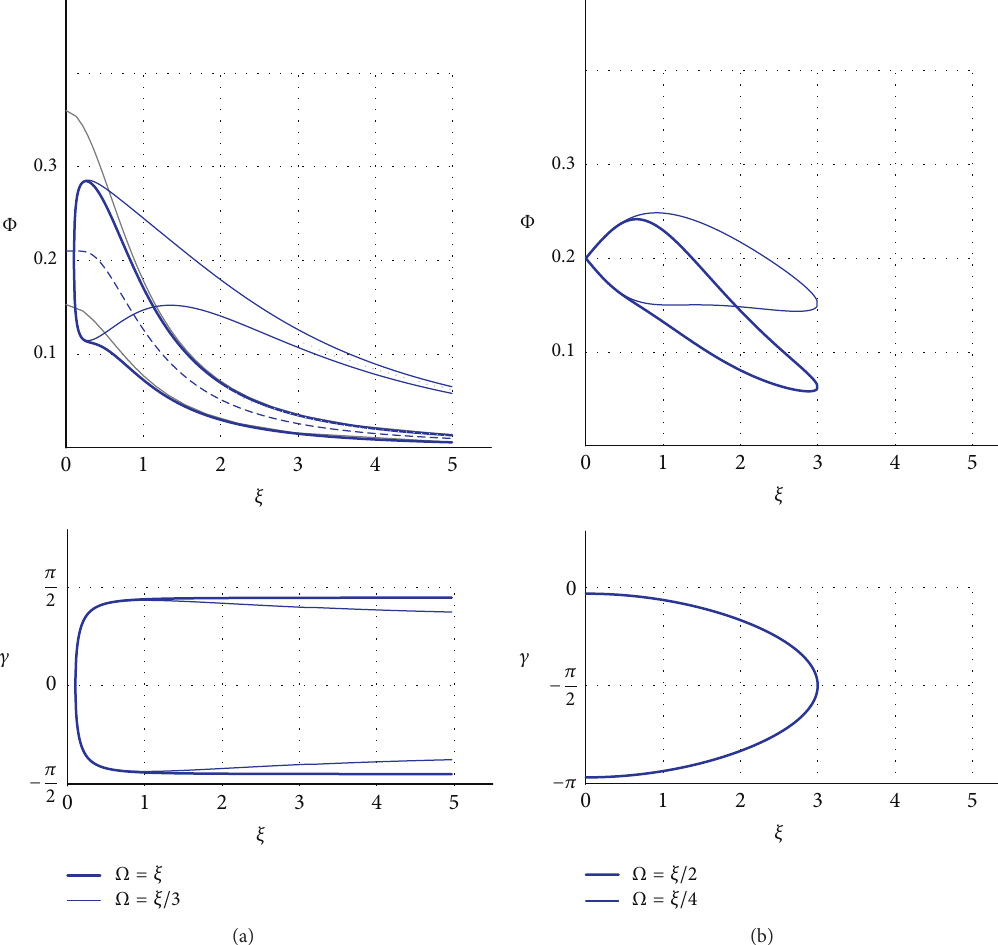
Figure 6: Amplitude- and phase-frequency characteristics of the system at different ratios Ω/𝜉